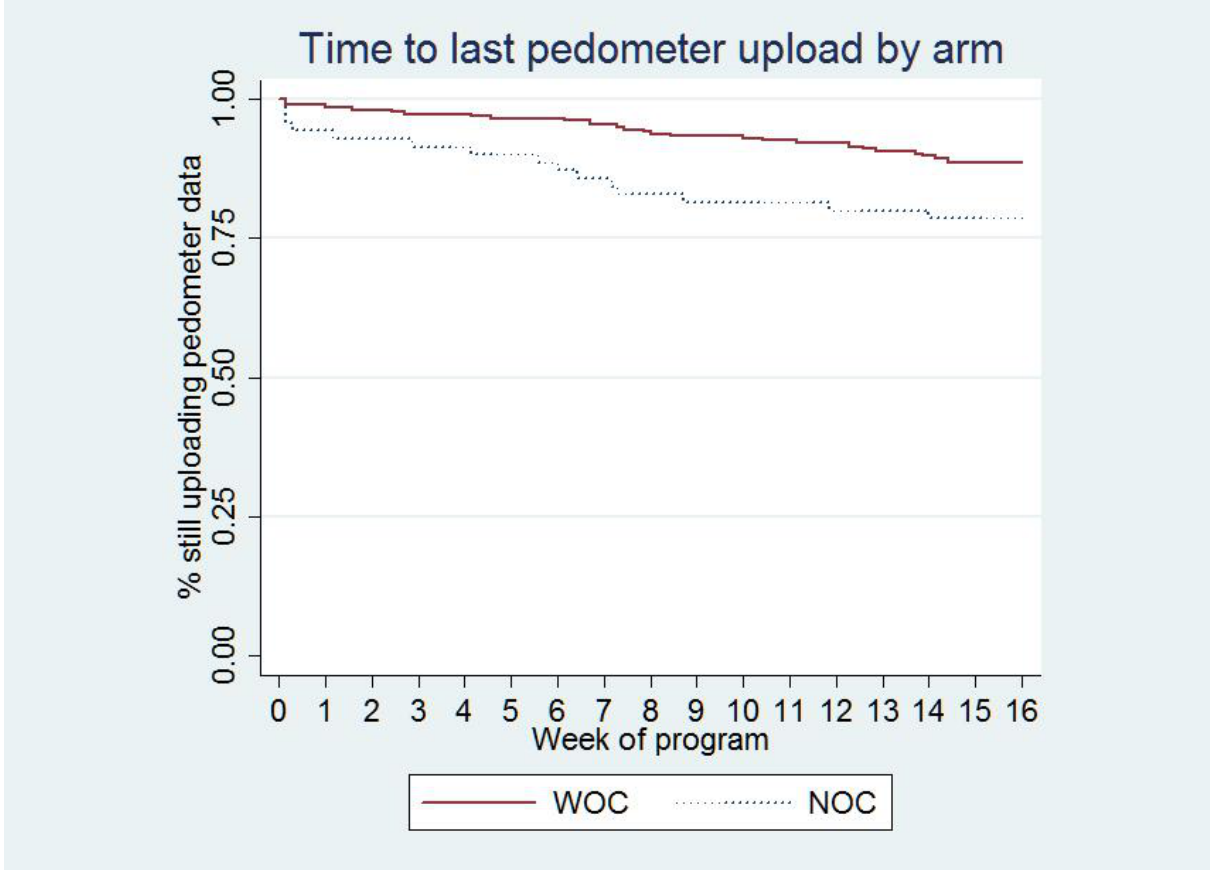
Figure 5. Time-to-event